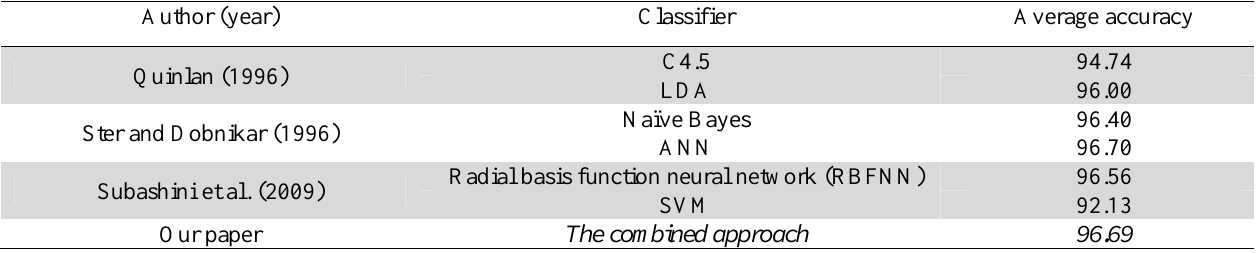
The proposed model in comparison with other classifiers in “Wisconsin Breast Cancer”